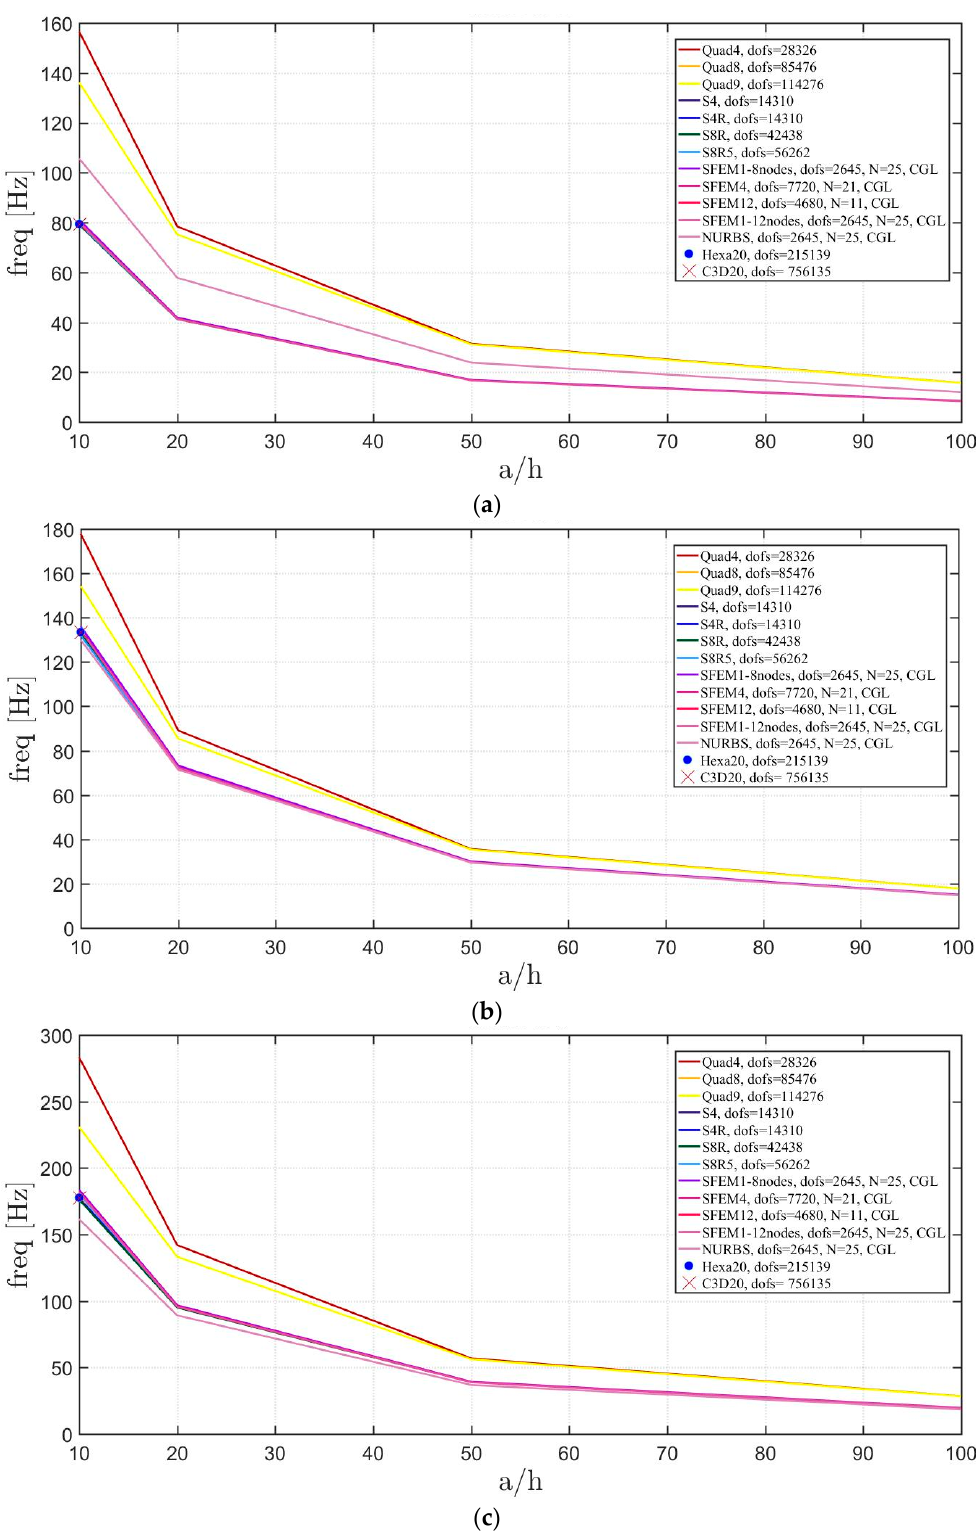
Figure 28. Thickness effect on the first three natural frequencies of an elliptic plate a / b = 2.5 with a symmetric lamination scheme: ( a ) First frequency; ( b ) Second frequency; ( c ) Third frequency.